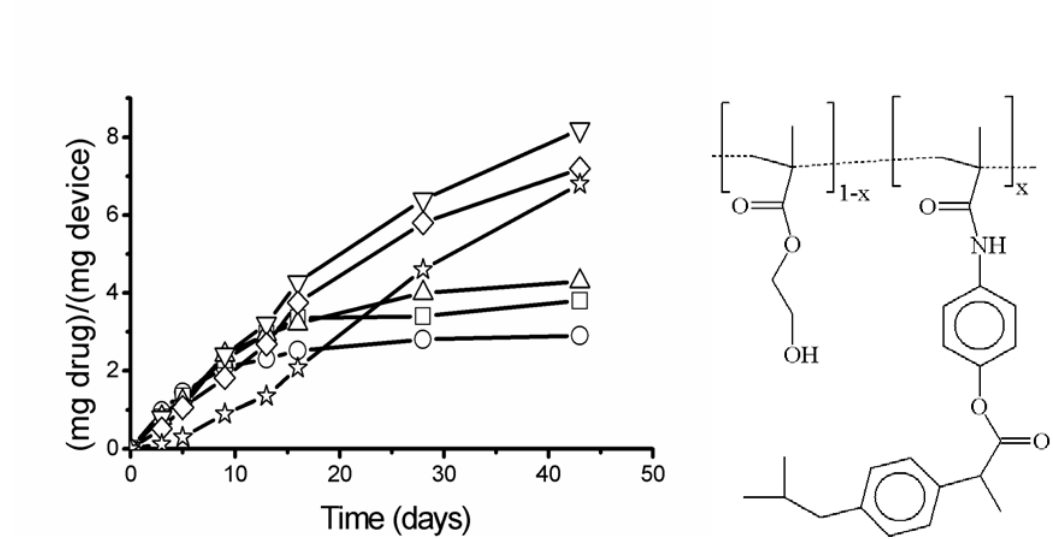
Figure 6 .- Drug release at pH = 7.4 as (mg drug)/(g device) as a function of the time for all the copolymeric systems of 2-hydroxyethyl methacrylate, HEMA, and a methacrylamide that incorporates ibuprofen: N-{4-[2-(4-isobutylphenyl) propionyloxy] phenyl} methacrylamide, MAI. The weight compositions of the systems are 1 ( ), 2.5 ( ), 5 ( ), 10 ( ), 20 ( ) and 30 % (